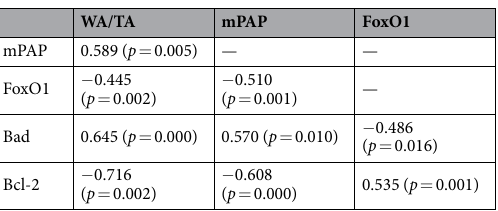
Table 5. Pearson correlation coefficients for mPAP, WA/TA, FoxO1, Bad, and